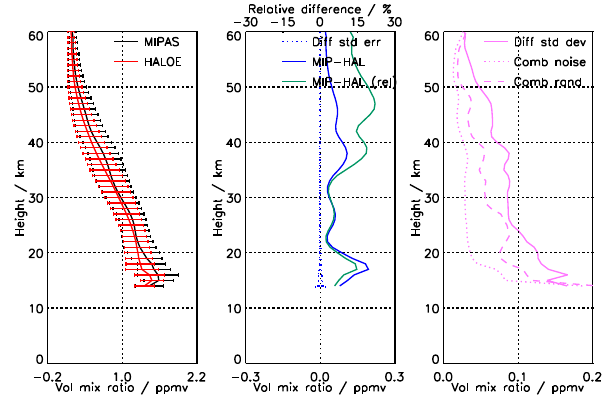
Figure 10. Comparison of CH 4 from HALOE and MIPAS full res- olution (V5H_CH4_21). Details as in Fig.